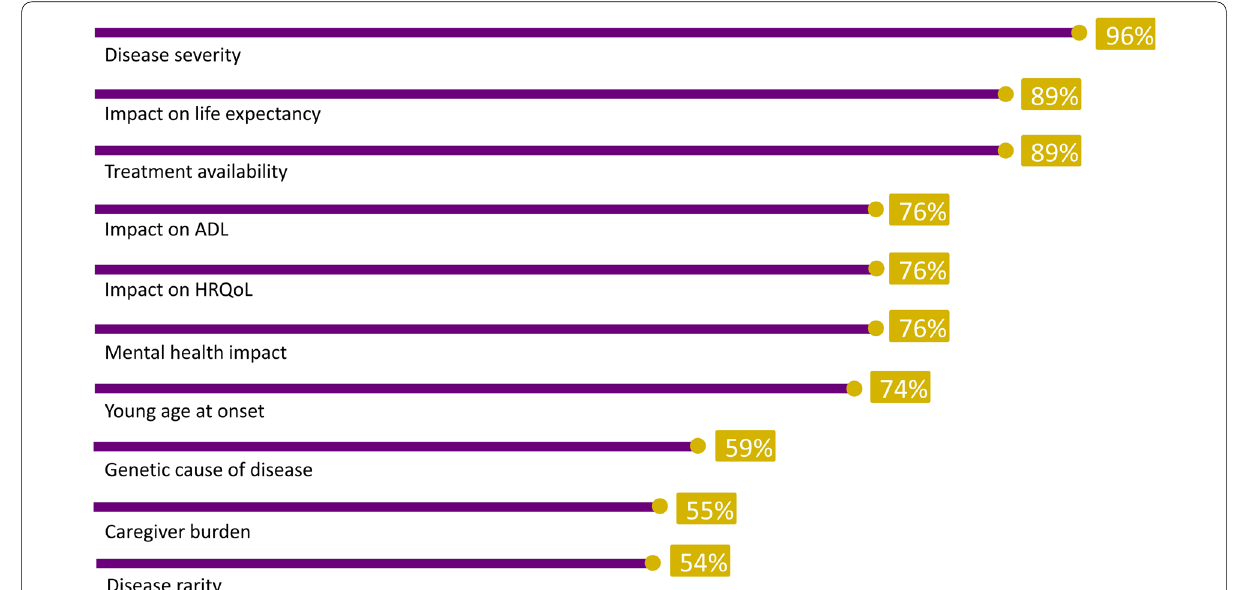
Fig. 2 The frequency with which participants ranked attributes as very or extremely important (n